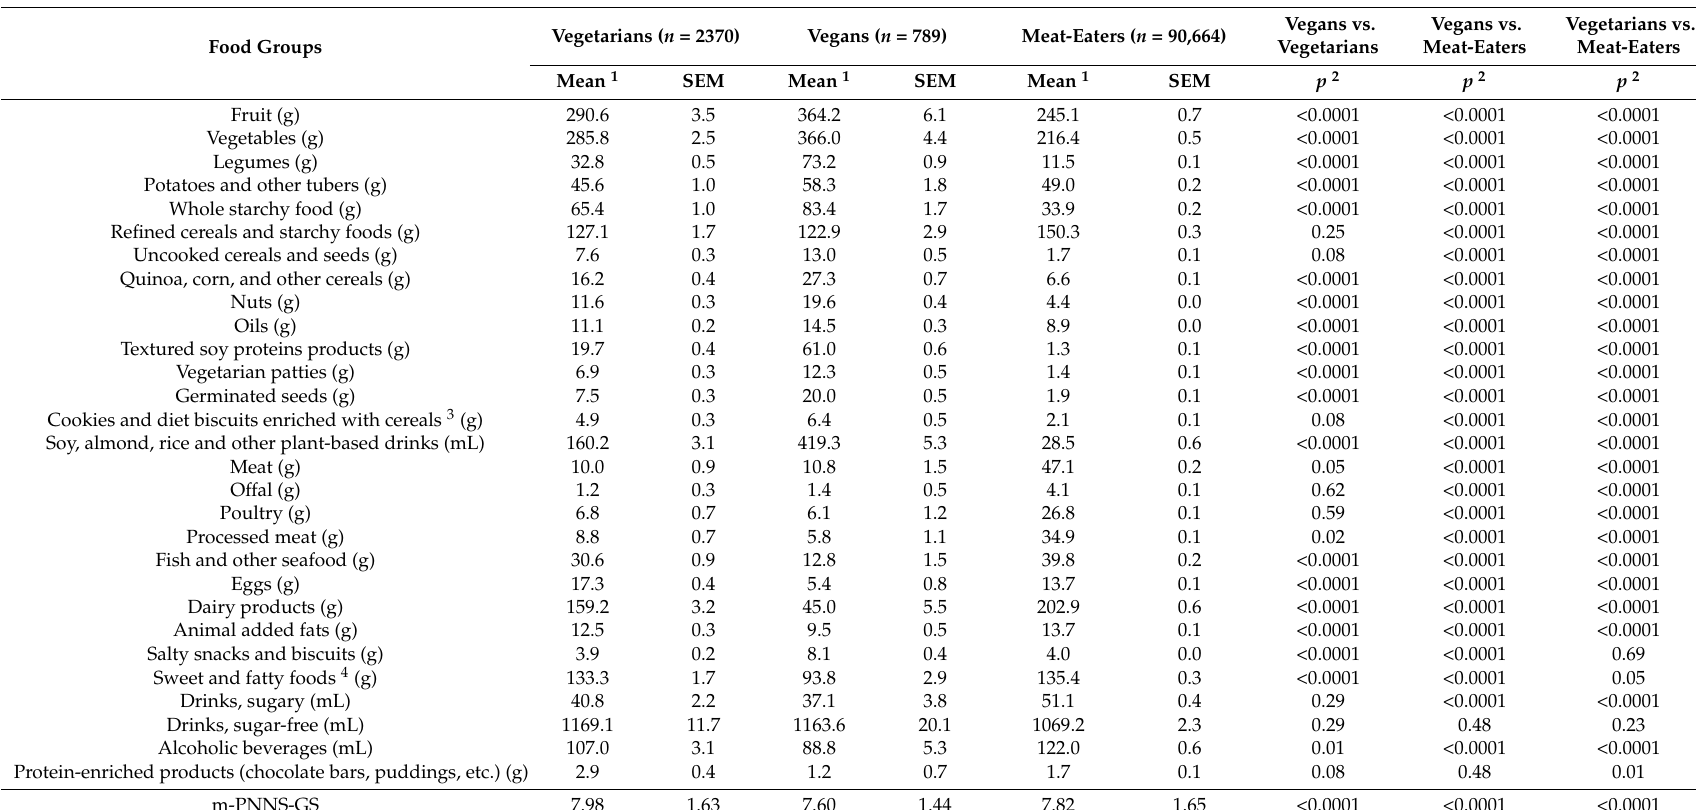
Table 3. Comparisons of mean intakes of food adjusted for sex, age, and total energy intake and mPNNS-GS among vegetarians, vegans, and meat-eaters (Nutrinet-Sant é Study 2009–2015, n =